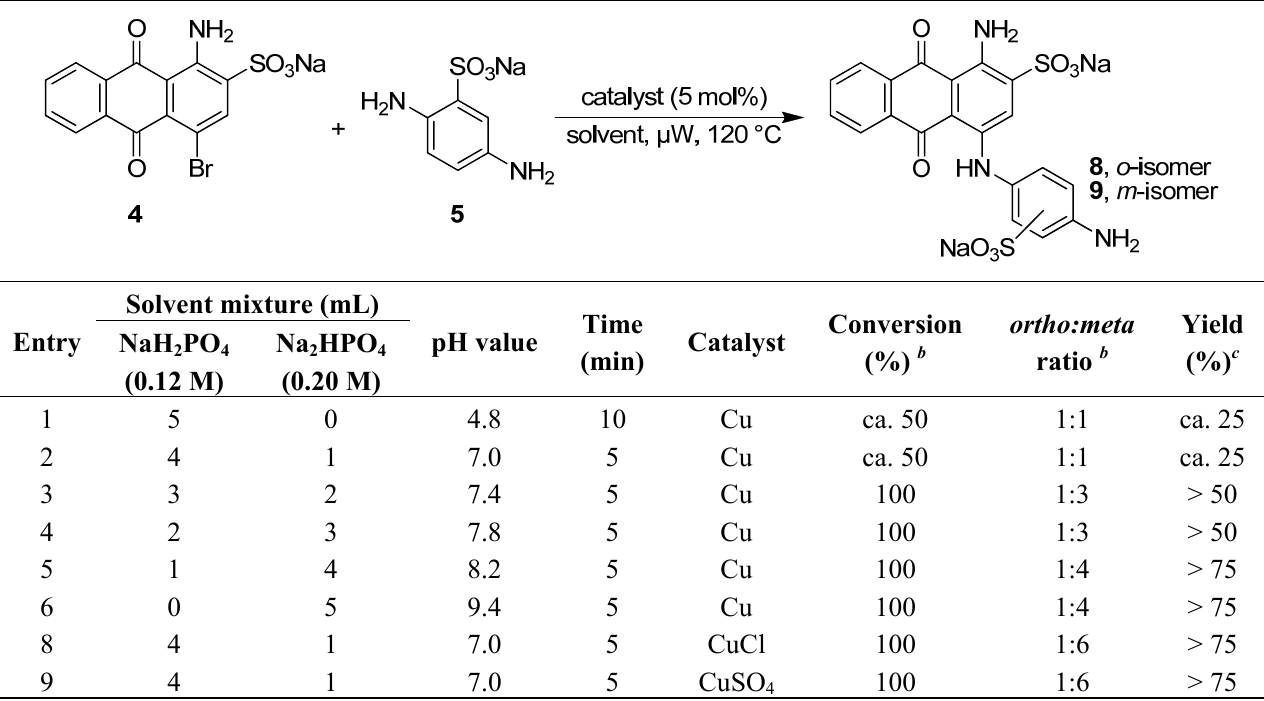
Table 2. Effects of different pH values on the copper-catalyzed coupling reaction